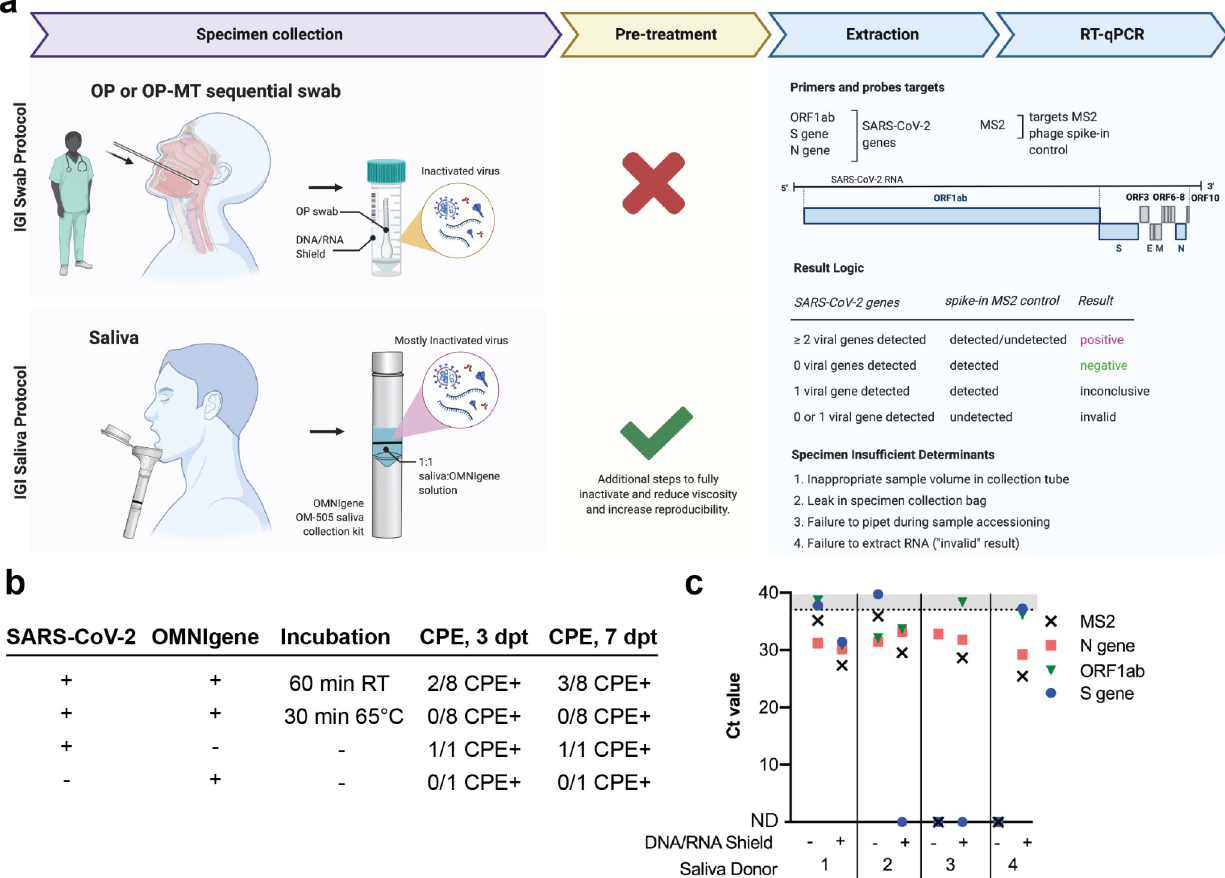
Fig 1. Overview of nucleic acid extraction from saliva specimens. a, Overview of Innovative Genomics Institute’s (IGI’s) specimen processing pipeline for both swab and saliva samples. OP = oropharyngeal. OP-MT = oropharyngeal-mid turbinate. b, Cultured SARS-CoV-2 (1.58x106 TCID50/ml) was mixed 1:1 with OMNIgene solution present in OM-505 collection tubes to test incubation conditions that inactivate viral replication. Samples were either held at room temperature (RT) or incubated at 65˚C for the indicated length of time before being applied to Vero-E6 cells. Cytopathic effect (CPE) was quantified at 3 and 7 days post treatment (dpt). c, 3:2 dilution of saliva samples with DNA/RNA Shield improves detection of spiked-in SARS-CoV-2 RNA or MS2 in four saliva donors. Figure made with Biorender.